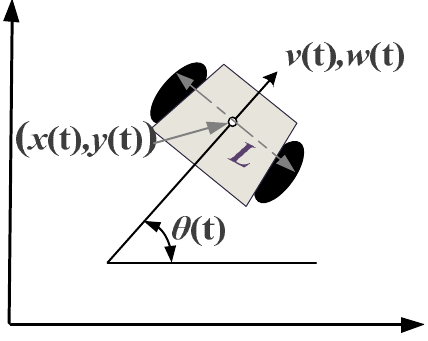
Figure 6. Robot kinematics model.